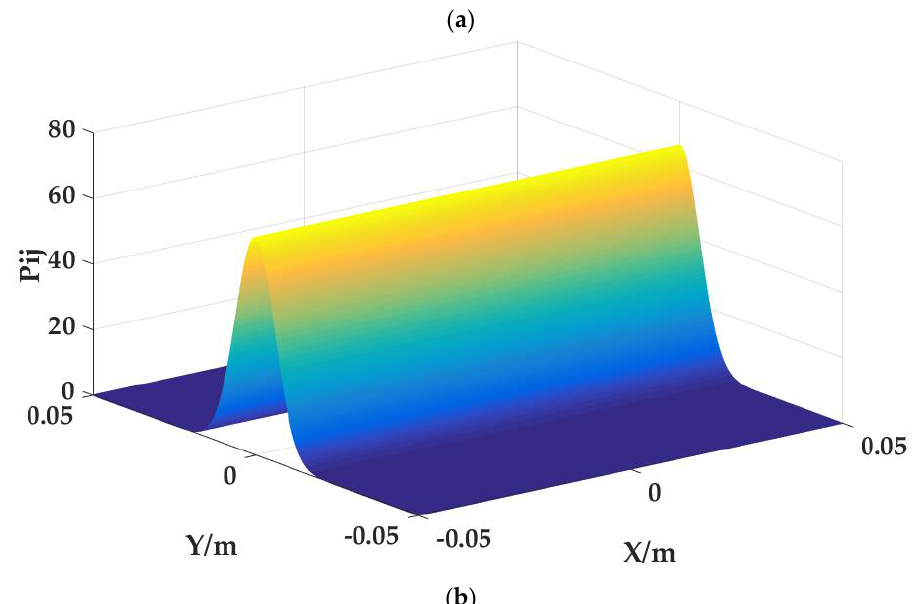
Figure 1. Probability distribution: ( a ) Probability scan path generated by the excitation and reception probe; ( b ) three-dimensional probability distribution.